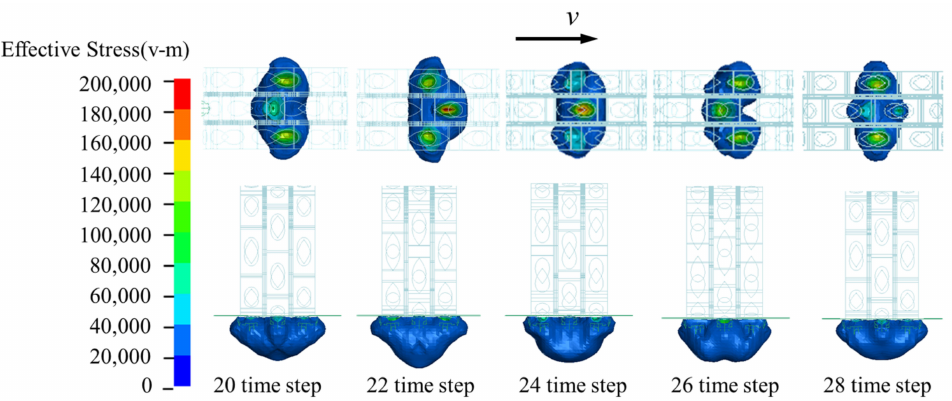
Figure 10. Stress change in stable stage (the direction of press roller movement is from left to